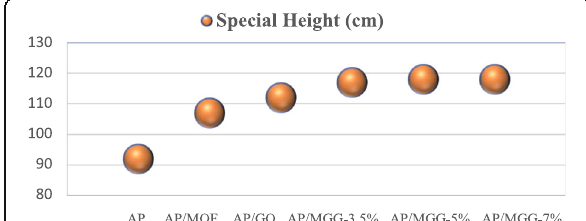
Fig. 10 Impact sensitivity of